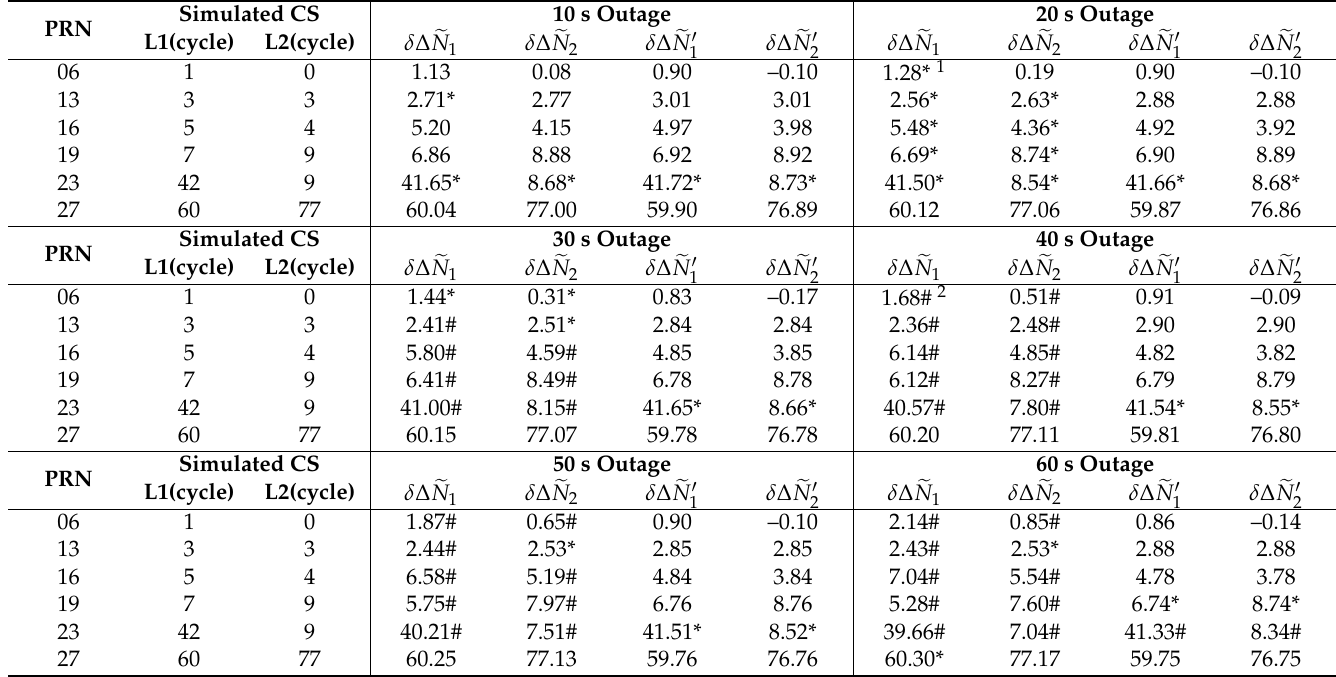
Table 2. Resolution of real cycle slips with signal interruption from 10 s to 60